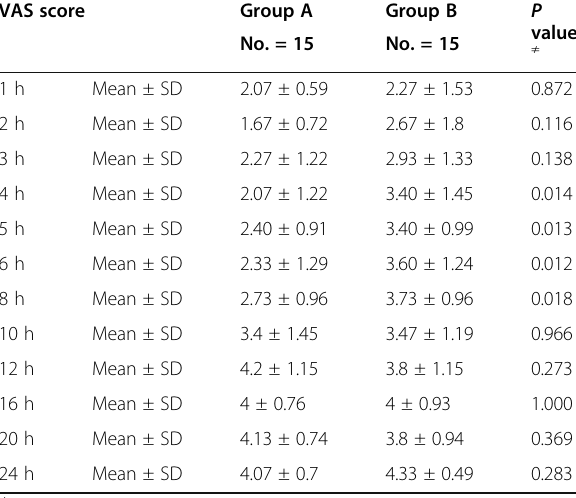
Table 5 Comparison between group A (Pecs) and group B (TPVB) regarding visual analog score